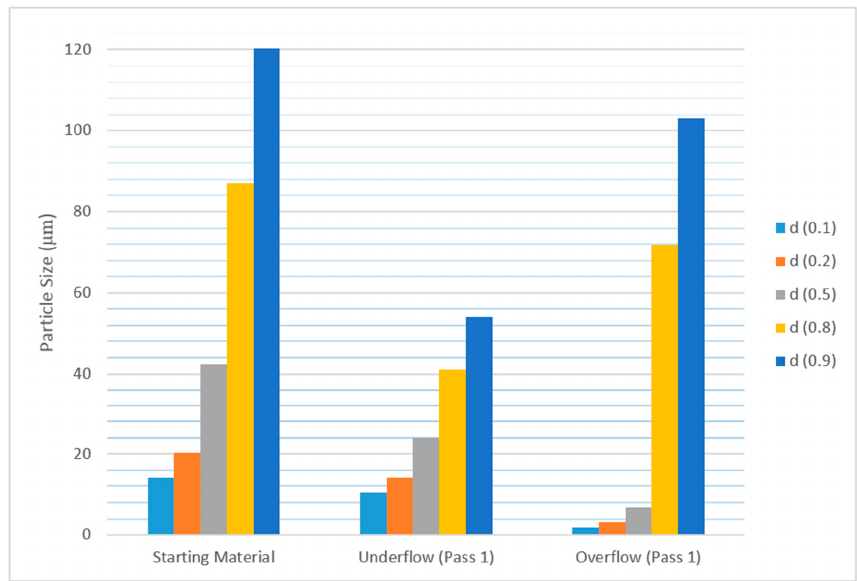
Figure 5. Particle size distribution in feed, underflow and overflow after first pass.